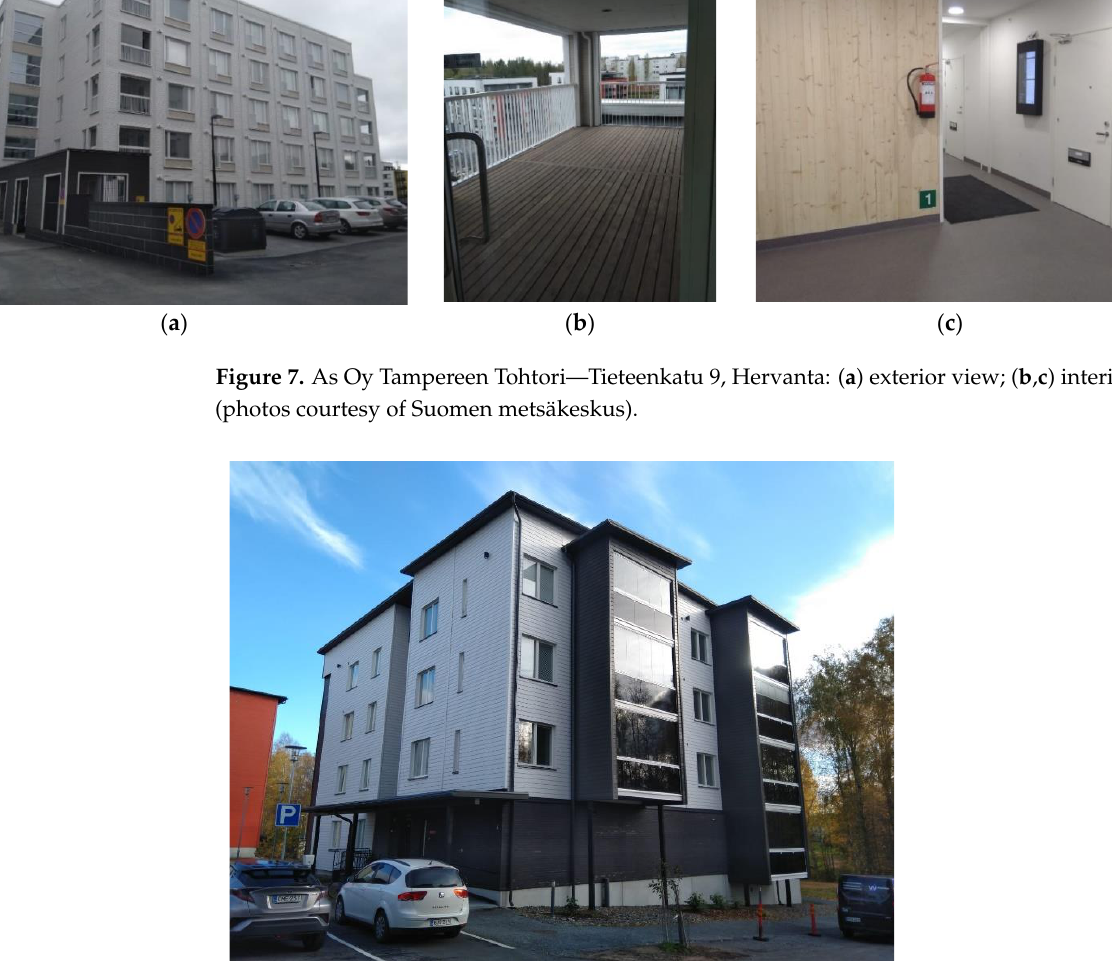
Figure 6. As Oy Tampereen Tuohi — Toivonkuja 3, Härmälä (photo courtesy of Suomen metsäkeskus).